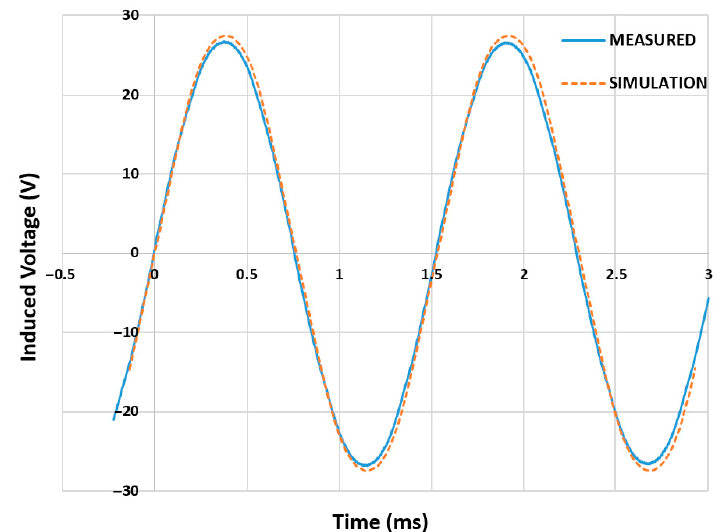
Figure 26. Measured and simulated line to line e.m.f.